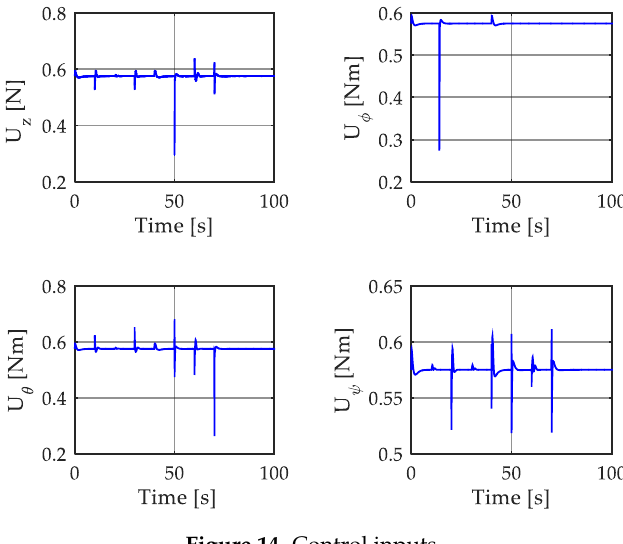
Figure 14. Control Figure 14. Control inputs. Figure 14. Control inputs. Figure 14. Control inputs.